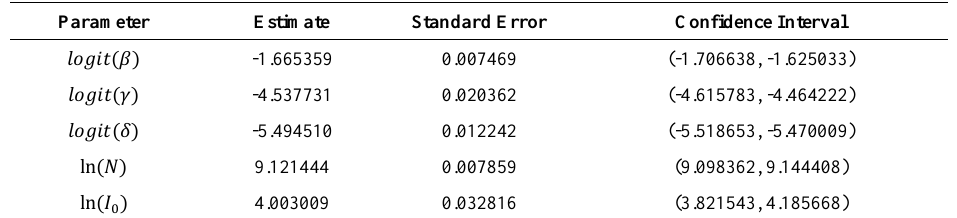
Table A23. Tuscany. Estimates, asymptotic standard errors, and 𝟗𝟓% profile likelihood mCIs for the parameters of the SIRD model